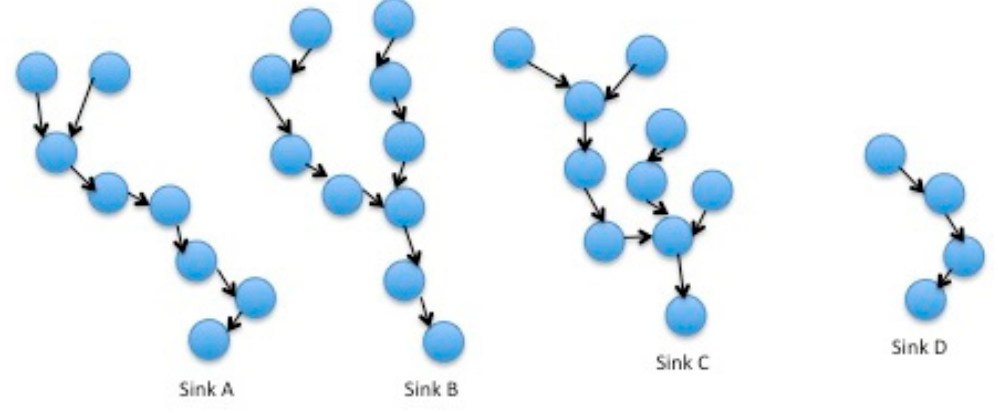
Figure 3. Phase 1: typical IEEE 802.15.4 clustered peer-to-peer ad hoc formation.